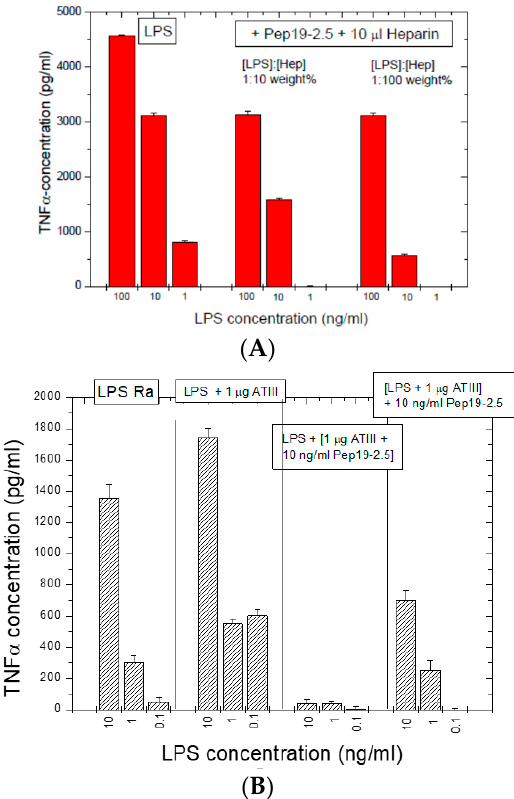
Figure 9. ( A ) Influence of heparin on the inhibition efficiency of Pep19-2.5. The amount of 10 µ L corresponds to 50 I.U. (international units). LPS was added at the given concentration to 5.0 × 10 6 hMNC, directly after the heparin and then, the peptide was added. Stimulation was performed for 4 h and then levels of TNF determination were performed. Mean values and standard deviations due to the determination of TNF α in duplicate. ( B ) Influence of anti-thrombin (AT)-III on the inhibition efficiency of Pep19-2.5 in the LPS-induced stimulation of human mononuclear